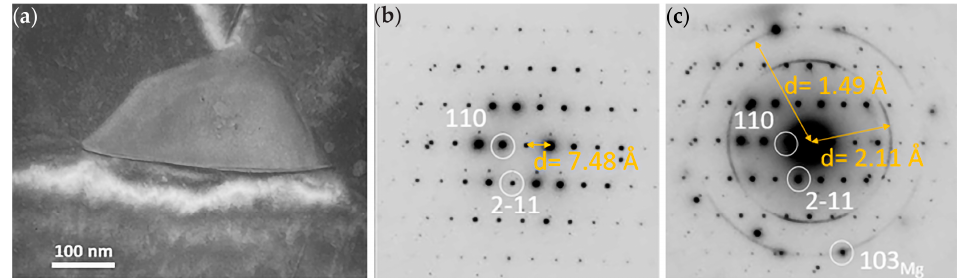
Figure 6. TEM images of alloy AZ61: ( a ) TEM micrograph of a Mg 17 Al 12 particle located on a triple point grain boundary with ( b ) corresponding [1 − 11] SAD pattern and ( c ) pattern including contributions from MgO (ring pattern) and Mg matrix (additional reflections).